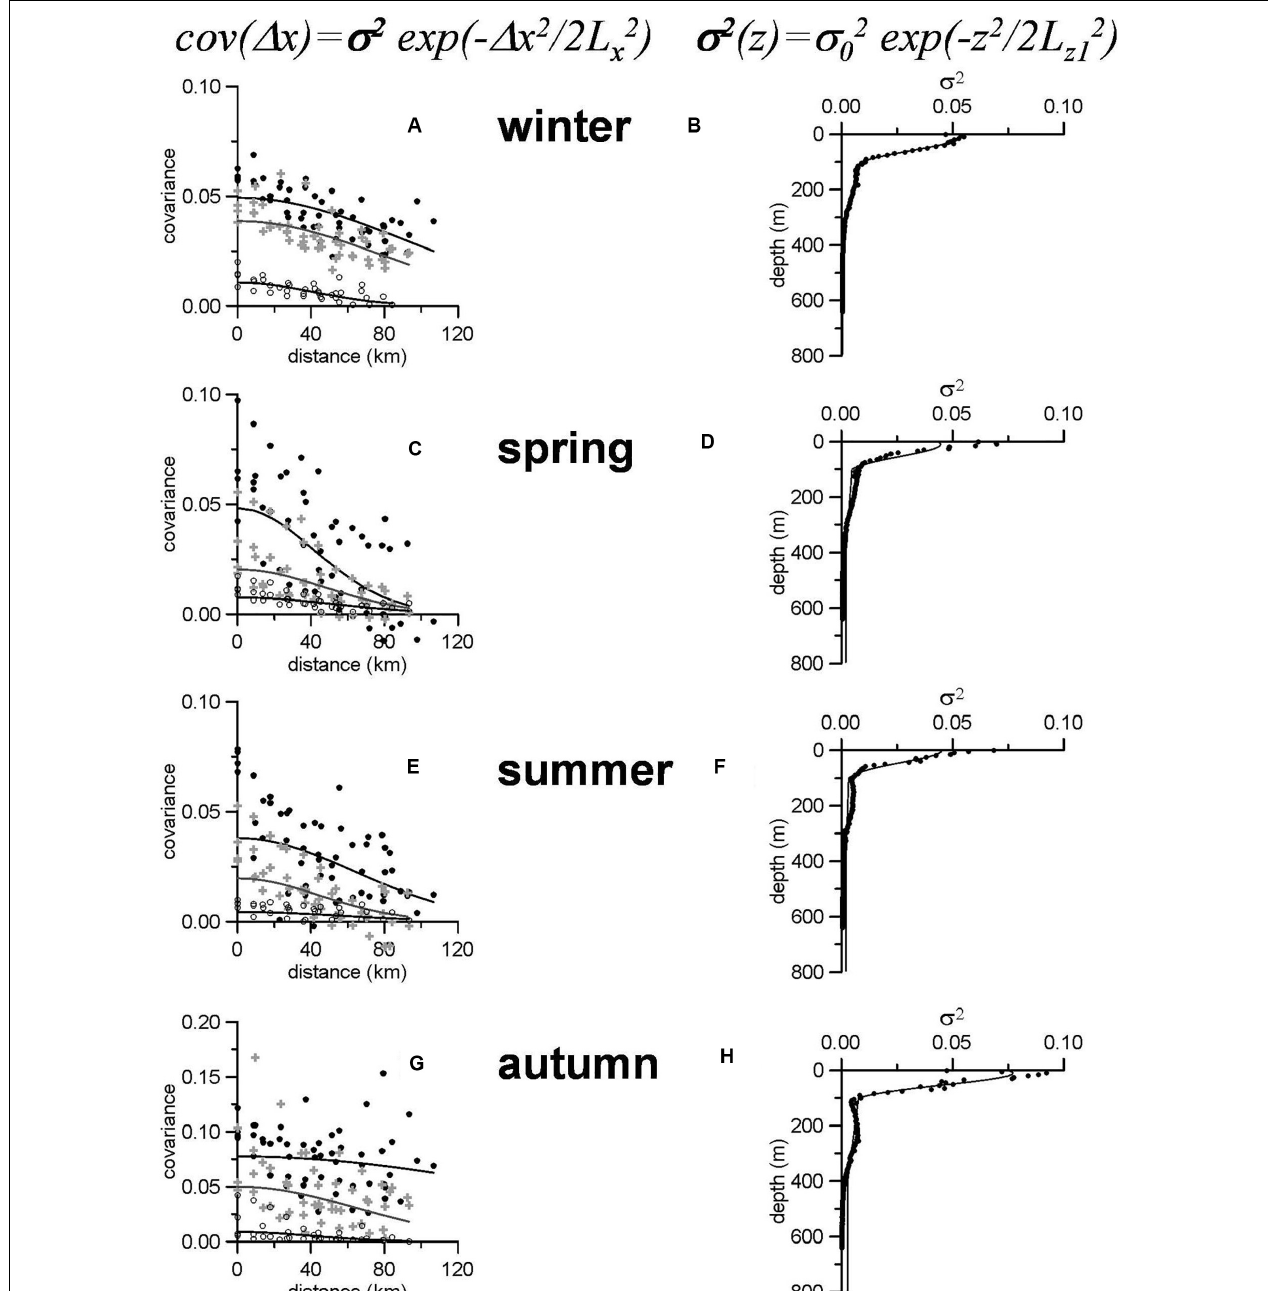
FIGURE 4 | ( A , winter), ( C , spring), ( E , summer), and ( G , autumn) are the salinity covariance as a function of the horizontal distance in km for the 25 (black dots), 50 (gray crosses) and 100 m (open circles) depths for the four seasons of the year. Solid lines are a Gaussian fit according to the formula on the left at the top of the panels. σ 2 is the variance for each depth level. ( B , winter), ( D , spring), ( F , summer), and ( H , autumn) show the depth dependence of the σ 2 value estimated for each depth level. This depth dependence for the upper 100 m is modeled by means of the formula on the right at the top of the panels. Then a linear decrease of the variance is assumed from 100 to 400 m, and a constant value below this depth